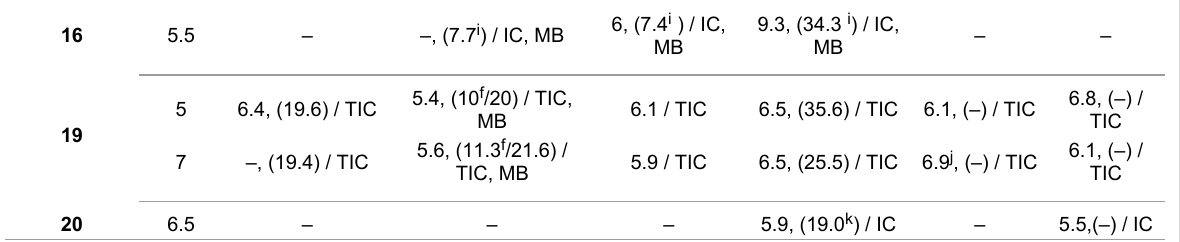
a Binding constants calculated from titration data by processing according to the Scatchard equation. b r = [compound]/[polynucleotide] = 0.2 if not stated otherwise. c IC = intercalation; MG = minor groove; NSA = non-specific agglomeration; GB = undefined groove binding; BIC = bis-intercalation; ESI = electrostatic interaction; HB = hydrogen bonding; PIC = partial intercalation; MB = mixed binding mode; TIC = threading intercalation. d Binding constants calculated from ethidium bromide displacement experiments [52]. e Biphasic thermal denaturation transitions at pH 5 due to different RNA forms [62]. f Biphasic thermal denaturation transitions due to b MB, values for both transitions given when possible. g Not possible to calculate due to systematic deviation of experimental data from best-fitted Scatchard isotherm. h Cumulative binding constants for mixed binding mode. i r = [com-